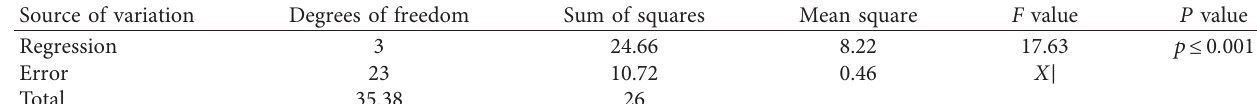
Table 6: ANOVA for the empirical model.